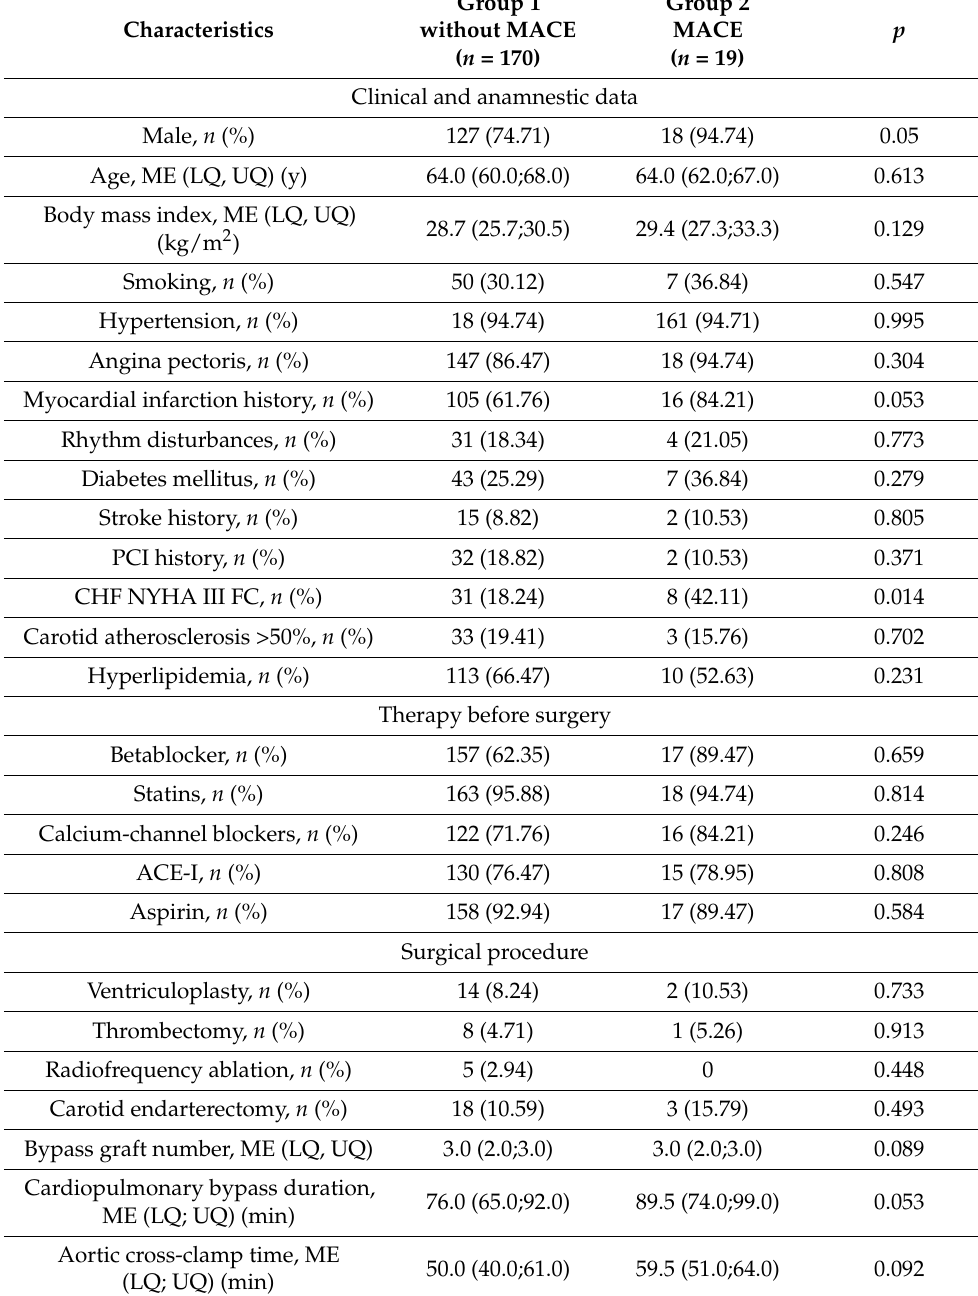
Table 1. Demographic data and clinical characteristics of patients with and without MACE 18 months after CABG. Group 1 Characteristics without